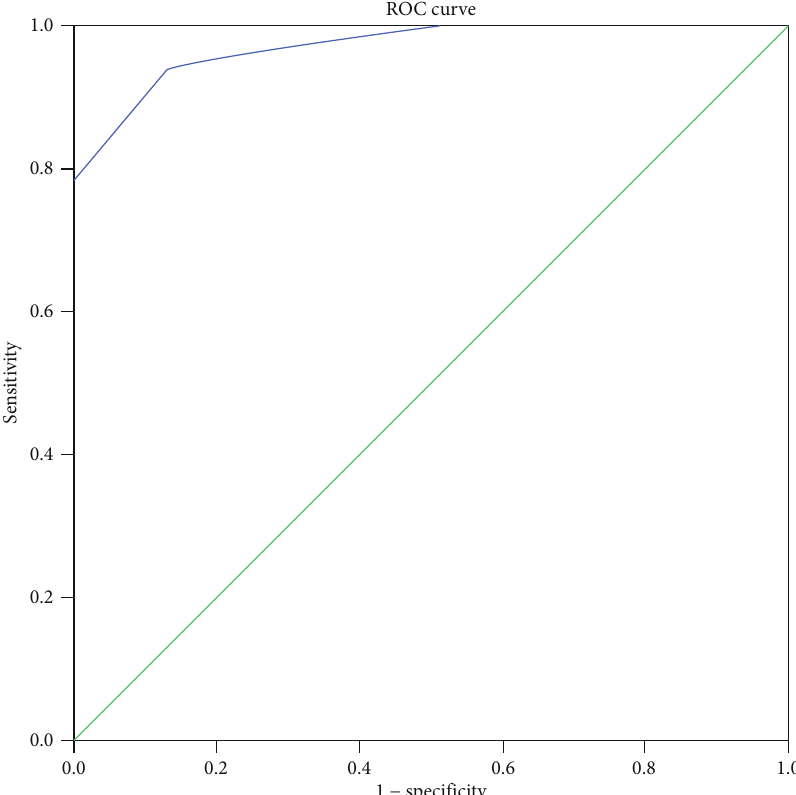
Figure 4: ROC curve discriminating between JME patients and HCs for FAB total score. Table 7: ROC cuto ff points for FAB total scores. Positive if greater